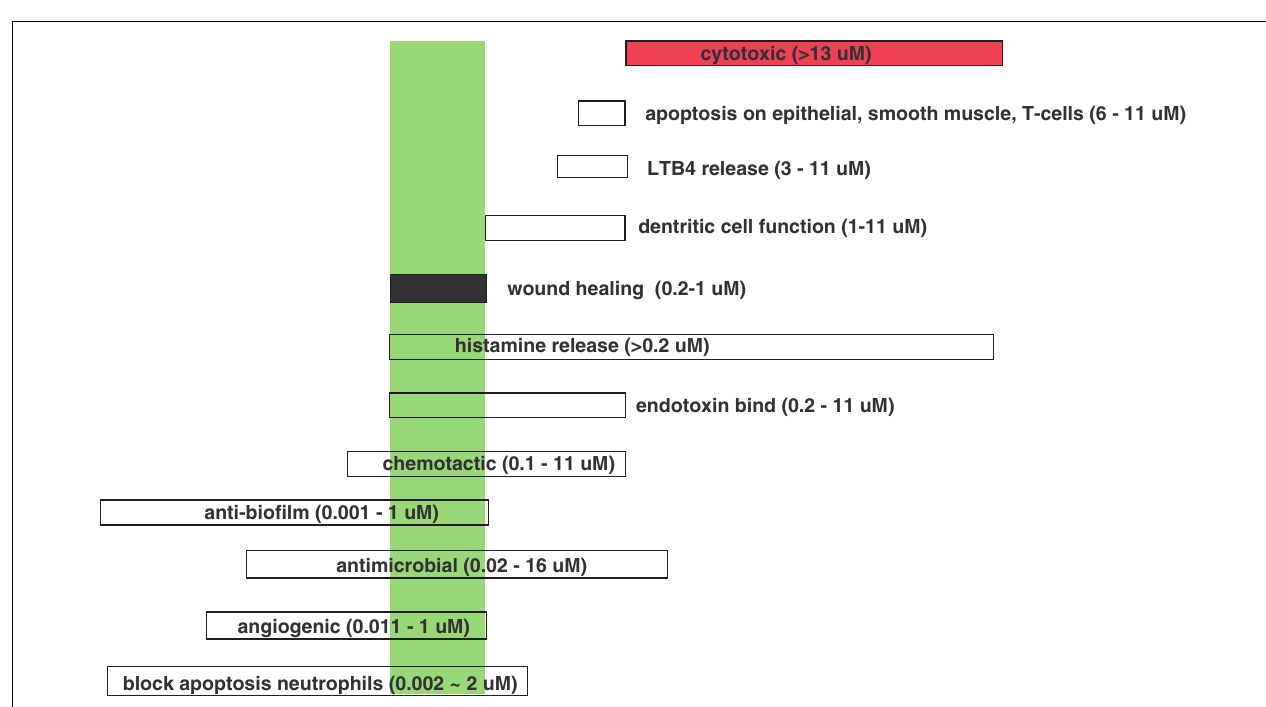
FIGURE 7 | Effective concentrations for the various, different activities of LL-37 . (Data from Kai-Larsen and Agerberth, 2008).The green box indicates the wound-healing concentration range of LL-37.